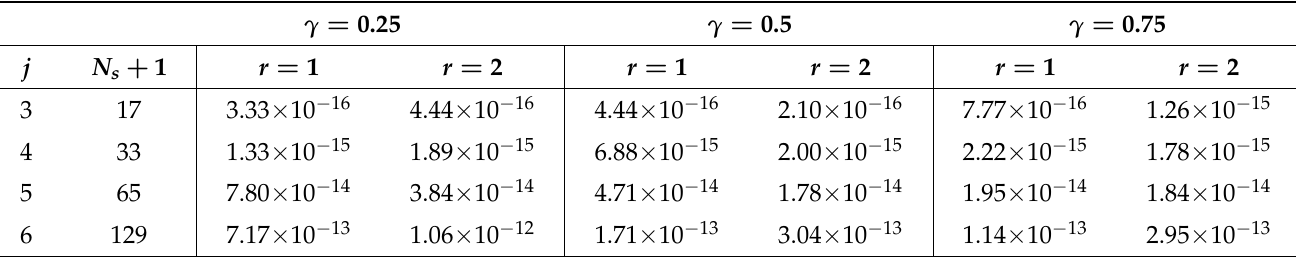
Table 1. Example 1: The infinity norm of the error (cid:107) e j (cid:107) ∞ for µ = 3 and different values of the fractional derivative γ and the refinement level j when using dQ 3 j y with r = 1 and r = 2 (cf. (26) and (27)). The number of collocation points is N s + 1 = 2 j + 1.